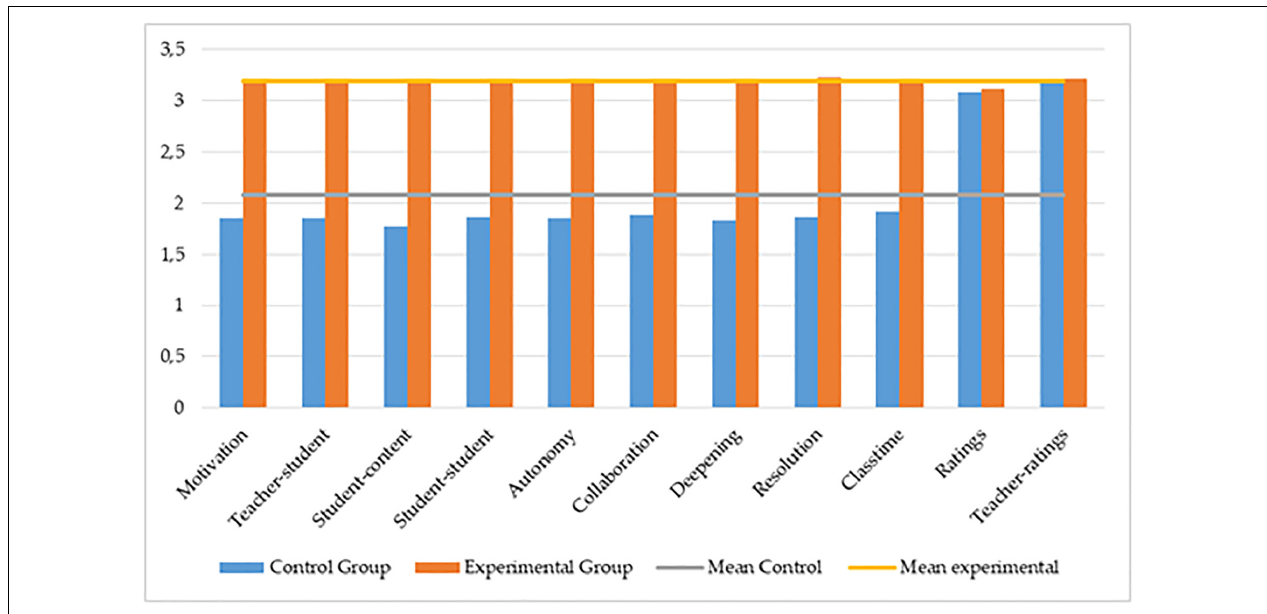
FIGURE 1 | Comparison between control group and experimental group.